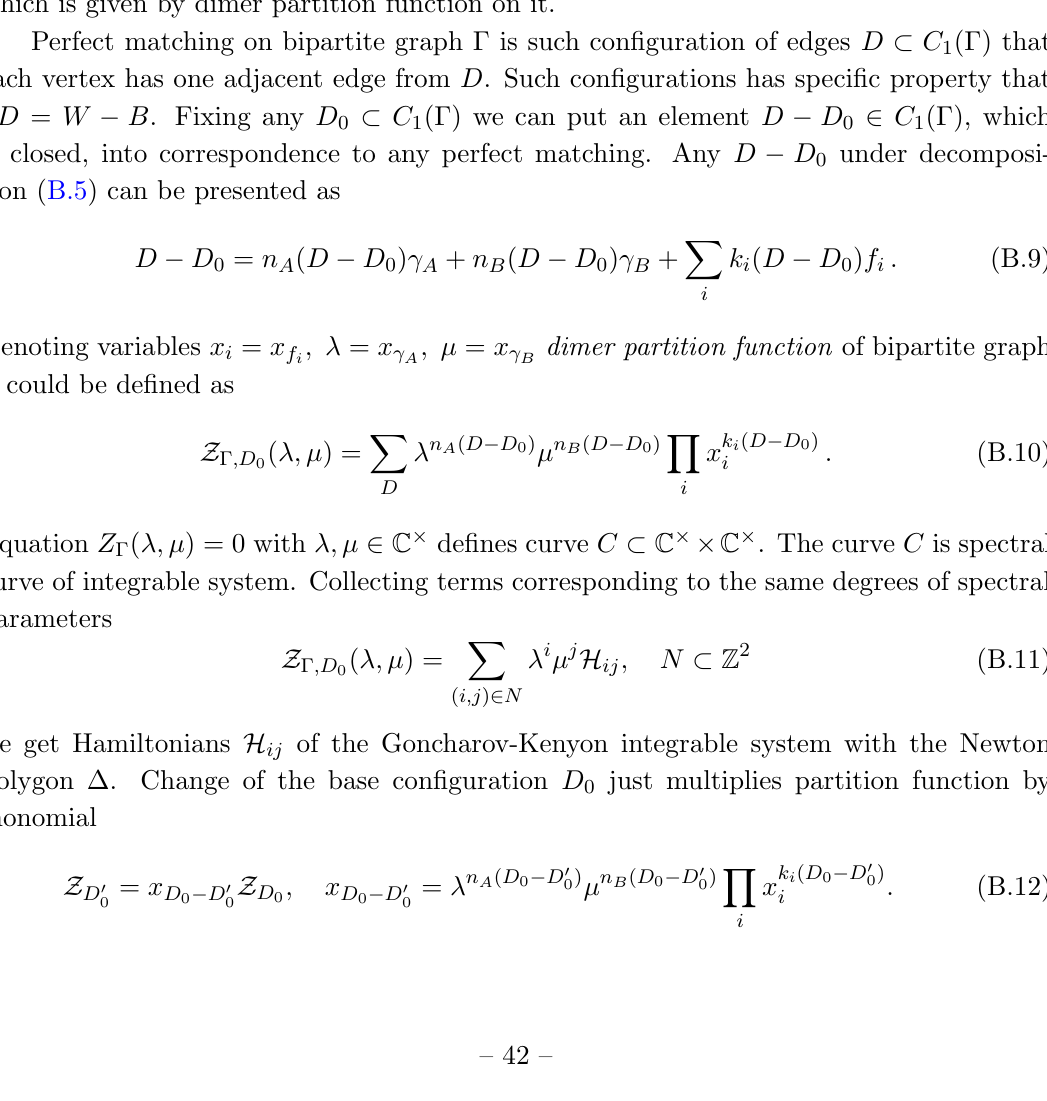
( T 2 ; Z ), so single zig-zag 1 x . (cid:11) (cid:12)